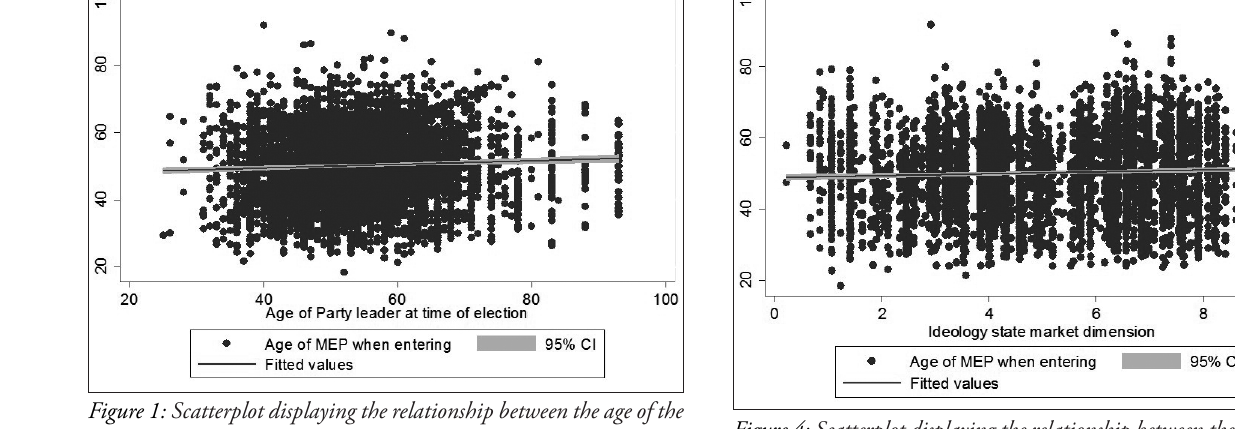
Figure 4: Scatterplot displaying the relationship between the ideology of the party (state/market dimension) and the age of MEPs from this party